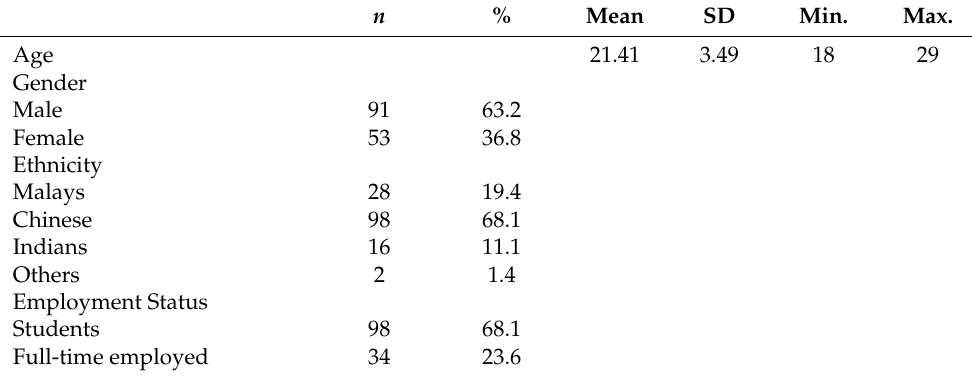
Table 1. Demographic information of the participants ( n =